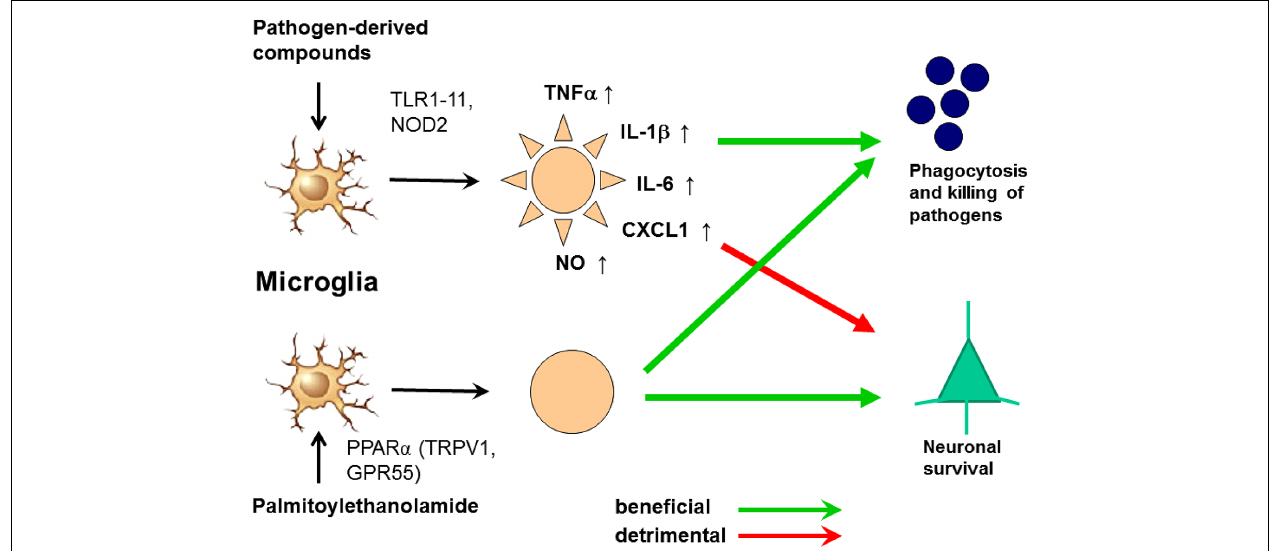
killing of pathogens.To our knowledge, it does not release proinflammatory mediators. For this reason we hypothesize that it will not cause collateral neuronal injury. PEA probably acts via the peroxisome proliferator-activated receptor (PPAR) α , but also is a ligand of the transient receptor potential vanilloid-1 (TRPV1) and the orphan G-protein coupled receptor GPR55 (De Petrocellis etal., 2001; LoVerme etal., 2005, 2006; Ryberg etal., 2007; Esposito and Cuzzocrea,